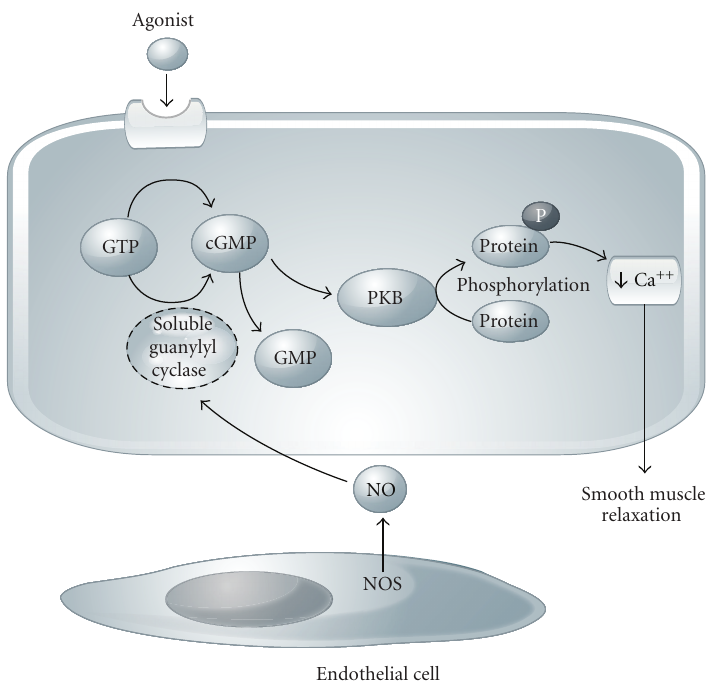
Figure 1: Simplified role of NO (nitric oxide) stimulating soluble guanylyl cyclase smooth muscle relaxation. PKB (protein kinase B), NOS (nitric oxide synthase).